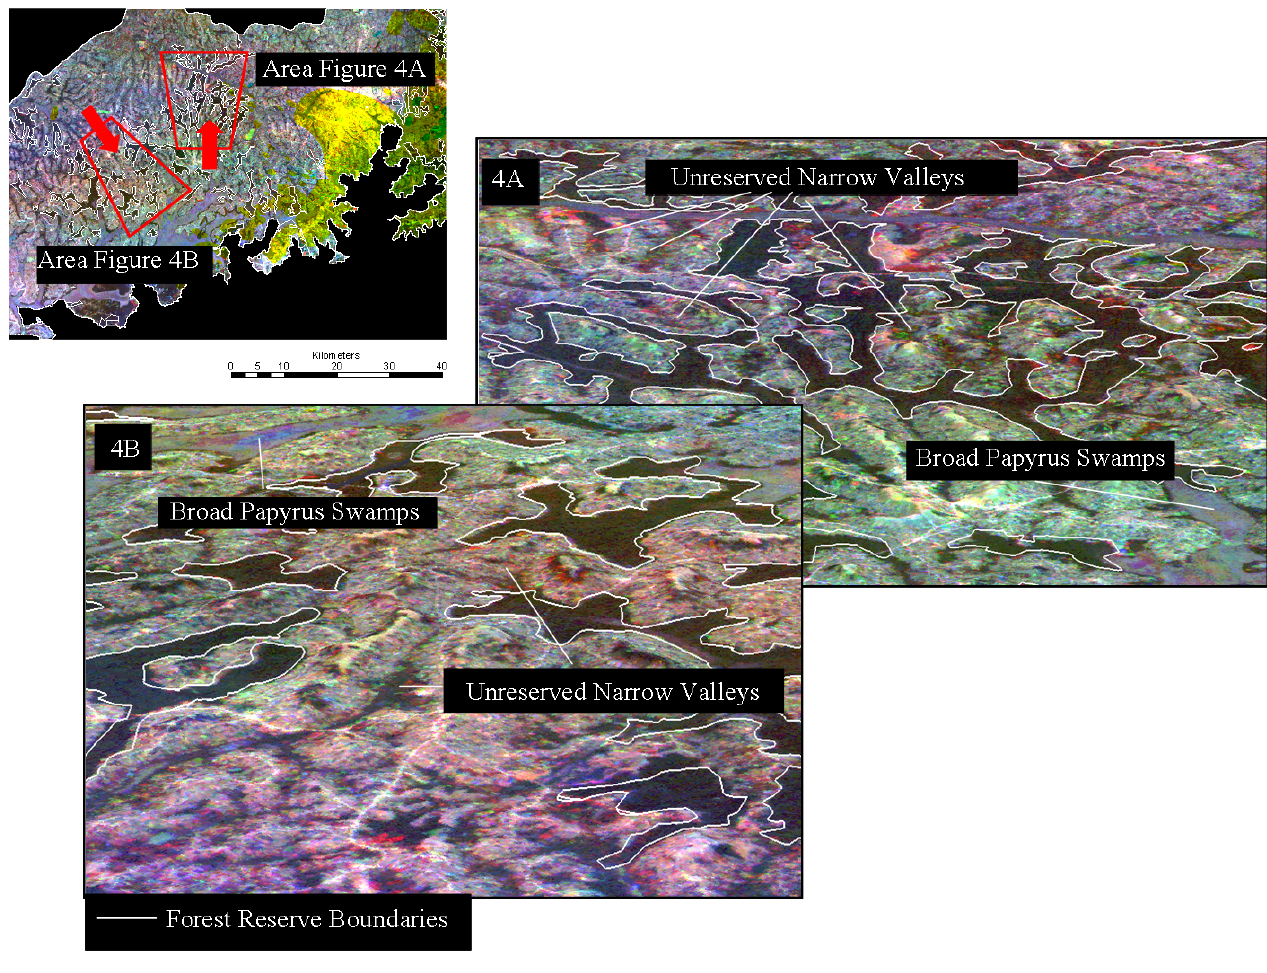
Fig. 4. Subsets of the multitemporal composite used in Fig. 2 are draped over a digital elevation model (DEM) to illustrate land cover in both reserved and unreserved narrow, seasonally inundated valleys, i.e., areas of similar soil types. Long-term forest cover stability, i.e., dark areas, on these soils types is observed almost exclusively within those valleys in which forest reserves were created. In unreserved valleys, forests are either absent, i.e., bright valleys, or we see evidence of heavy harvesting or occasional cropping in the remaining extent of forest, i.e., red and green speckles. The composite was constructed by Sean